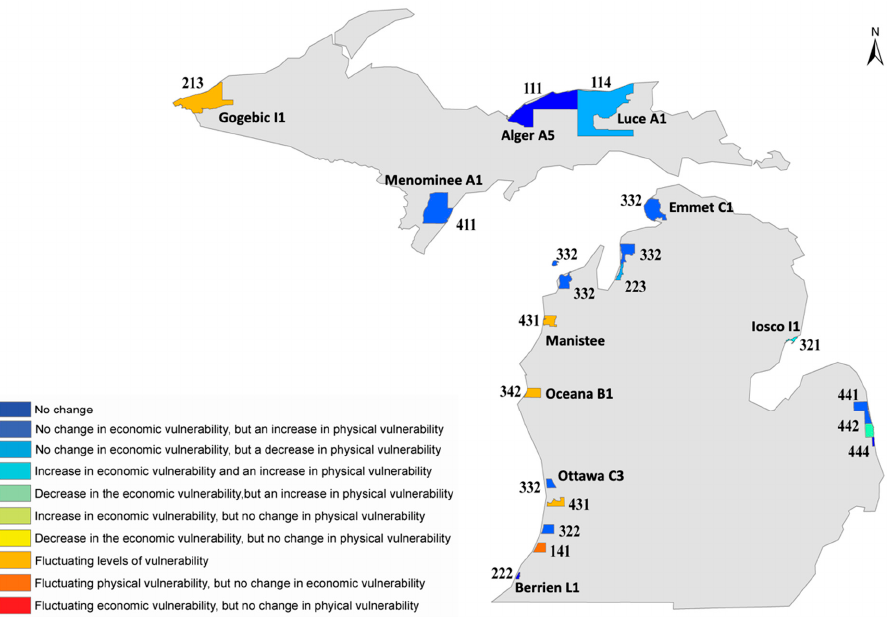
Figure 7. Typology Change Trajectories.